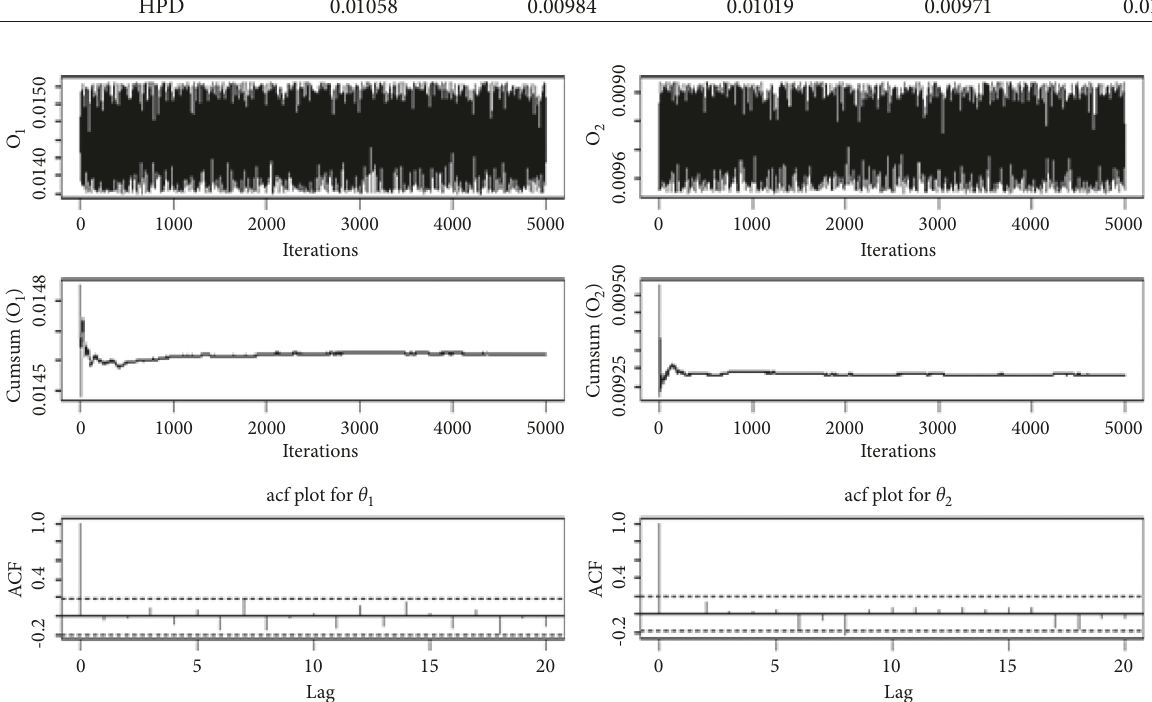
and θ of MCMC-generated 1 2